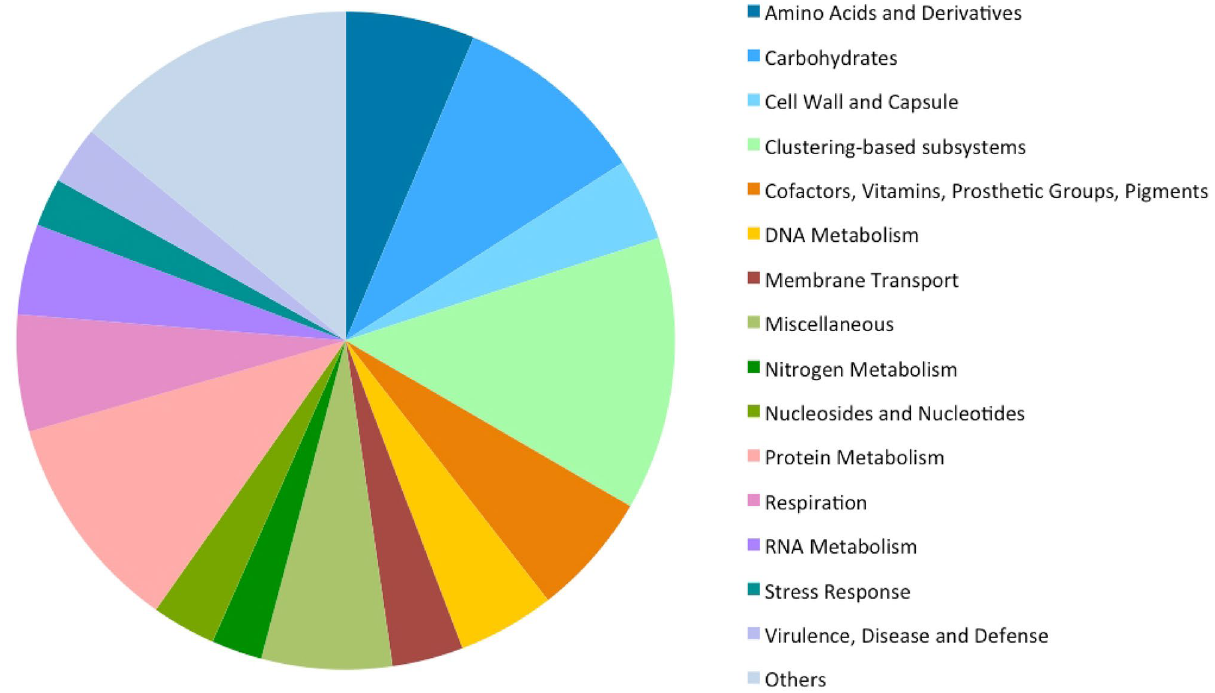
Figure 2. Functional profile of As Burgas hot spring at SEED subsystems level 1. Of 347,814 and 368,188 protein-coding regions predicted from BW1 and BW2 reads by MG-RAST, 52.1% (181,371) and 52.8% (194,410) were assigned by MG-RAST to SEED functional categories (Subsystems). The percentage of reads assigned to each function is represented. Others include those functions with less than 2.11% reads assigned (Cell Division and Cell Cycle; Dormancy and Sporulation; Fatty Acids, Lipids, and Isoprenoids; Iron acquisition and metabolism; Metabolism of Aromatic Compounds; Phages, Prophages, Transposable elements, Plasmids; Phosphorus Metabolism; Photosynthesis; Potassium metabolism; Regulation and Cell signaling; Secondary Metabolism; Sulfur Metabolism; Motility and Chemotaxis). Graph was created with Excel for Windows version